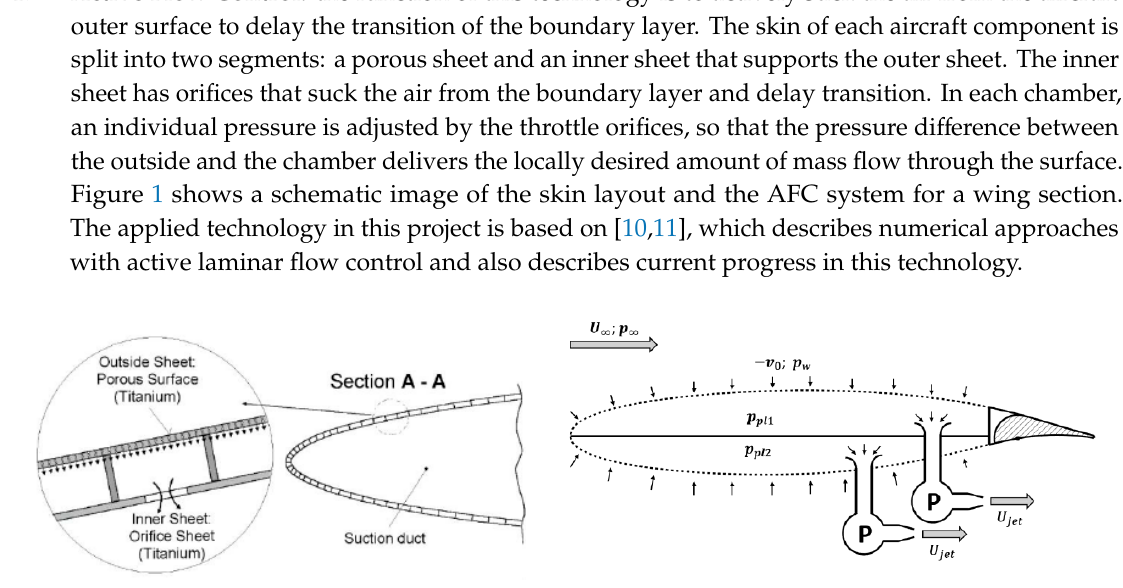
Figure 1. Schematic views of the active suction system [10].